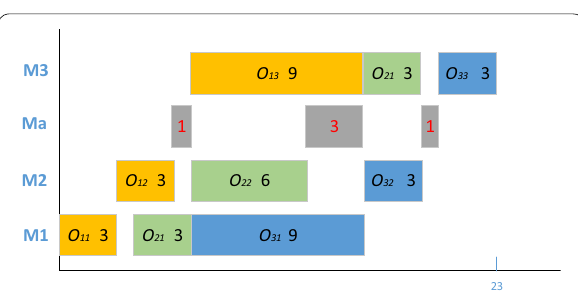
Figure 13 The Gantt chart added with free time in